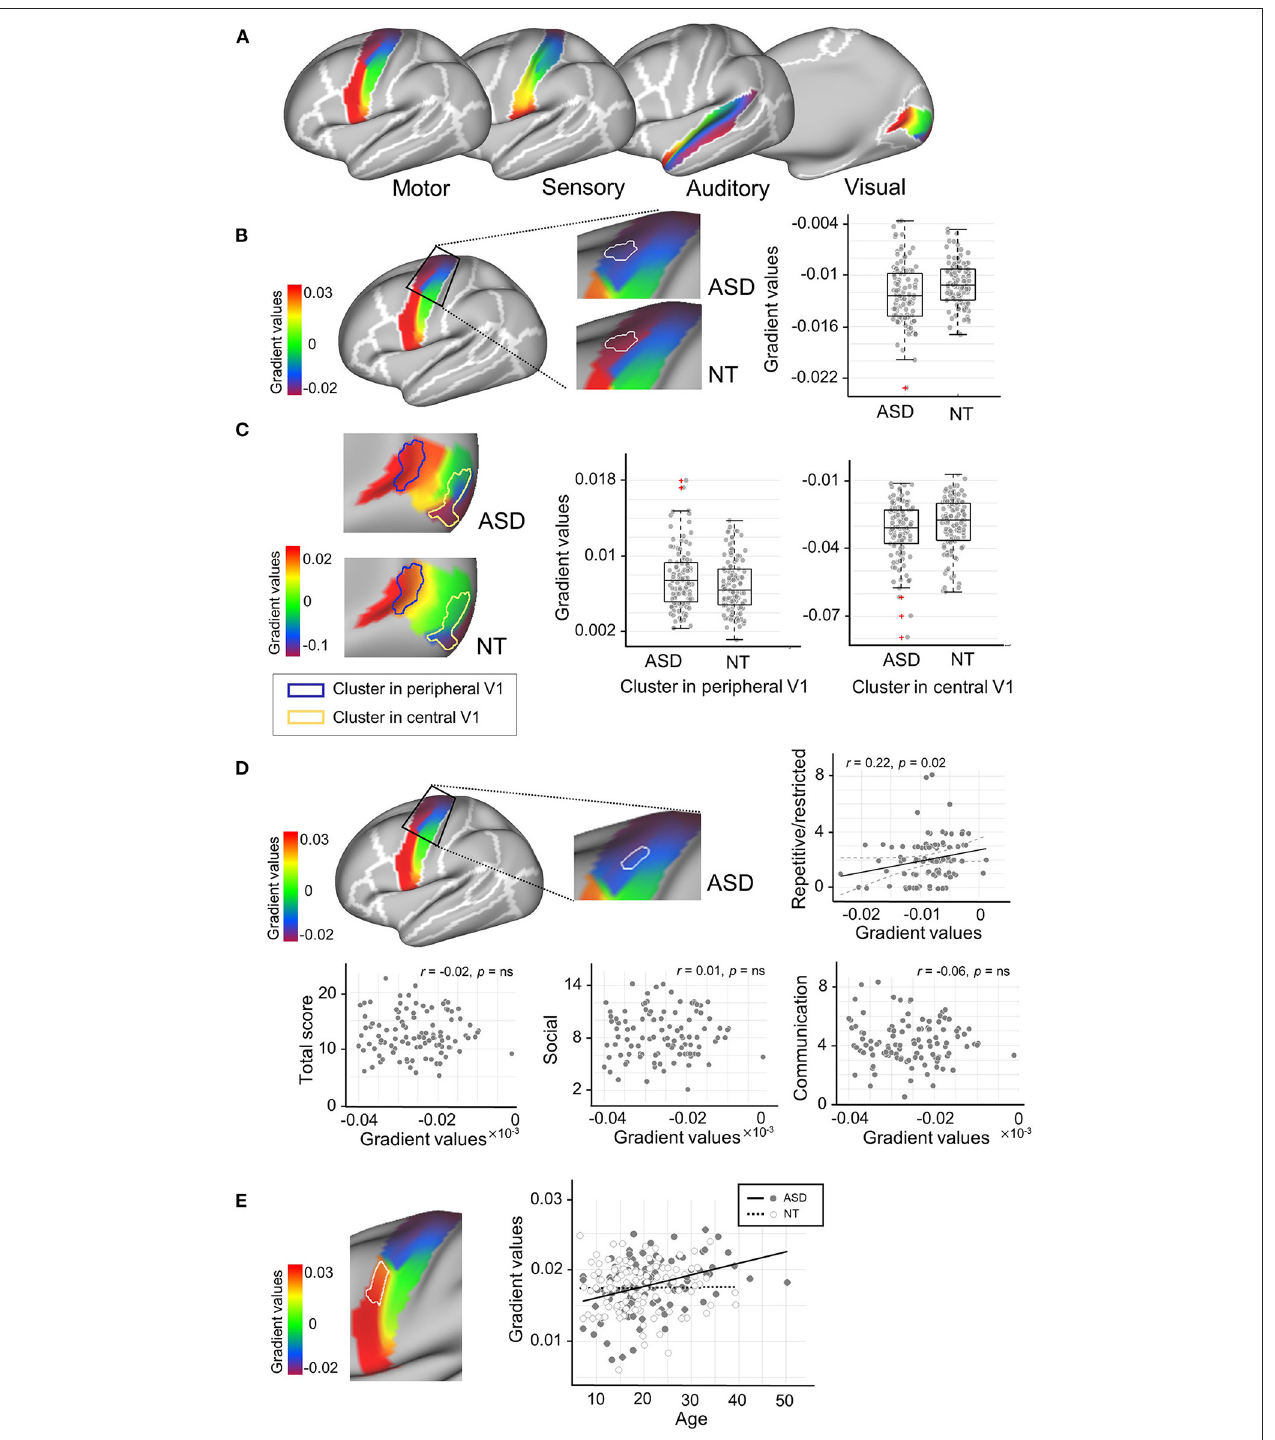
FIGURE 1 | Connectopic mapping analysis. (A) The functional gradient maps of neurotypicals (NT) for low-order sensory/motor regions are presented. The motor (precentral), sensory (postcentral) and auditory (transverse and superior temporal) masks are derived from the Desikan-Killiany atlas, while the visual mask is from the Brodmann Area (BA) atlas corresponding to the primary visual area (BA 17). (B) The cluster that showed significant group difference in M1 Upper is marked in solid, white outlines. More extreme negative gradient scores were found in the ASD group, indicating an abnormally more segregated intrinsic functional connectivity (iFC). (C) The clusters that showed significant group differences in V1 Central and V1 Peripheral are marked in yellow and blue solid outlines, respectively. This central-to-peripheral gradient expansion in ASD indicates that iFC in the visual region becomes more segregated in ASD. (D) A cluster in M1 Upper showed significant associations with ADOS scores for restricted and repetitive behavior in ASD. (E) The cluster that showed a significant age-by-group interaction effect is marked in solid, white outlines. ADOS, Autism Diagnostic Observation Schedule.